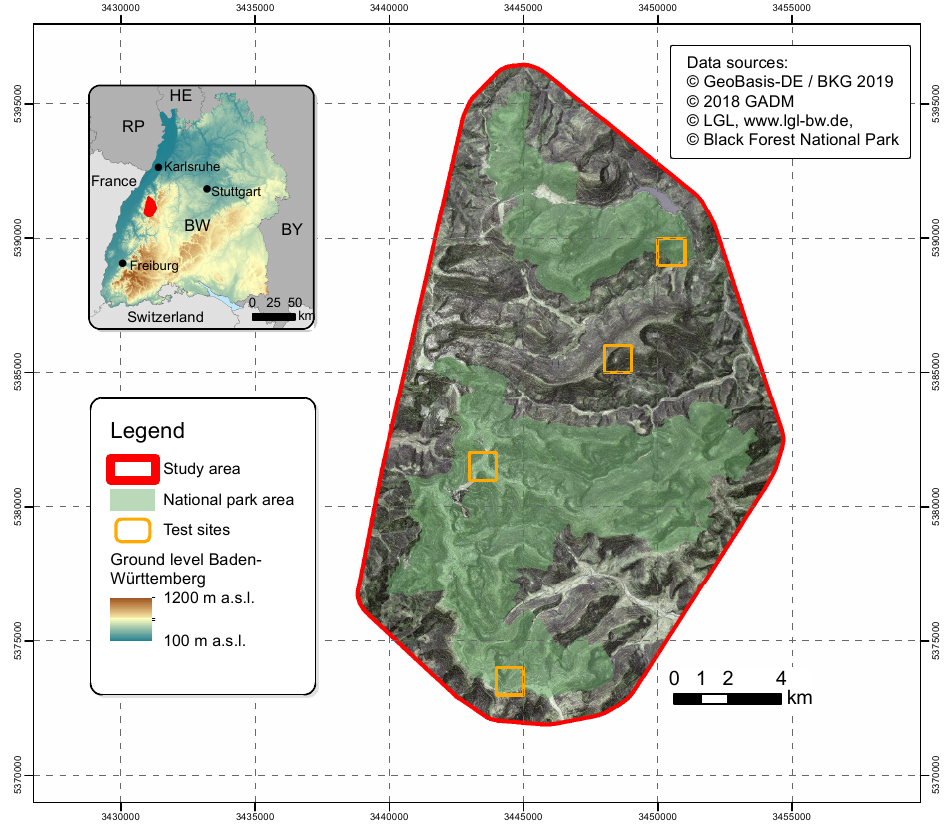
Figure 1. Map of the study area and location of test